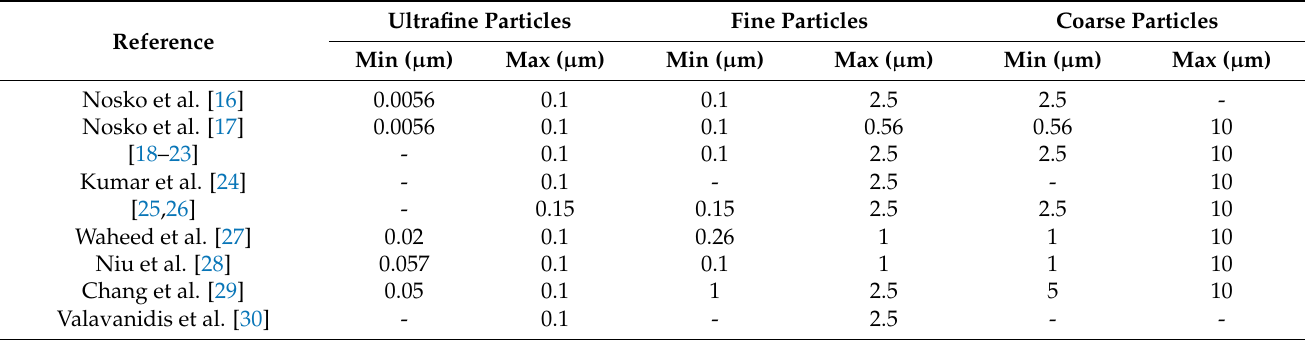
Table 2. Minimum and maximum sizes of particles considered in previous